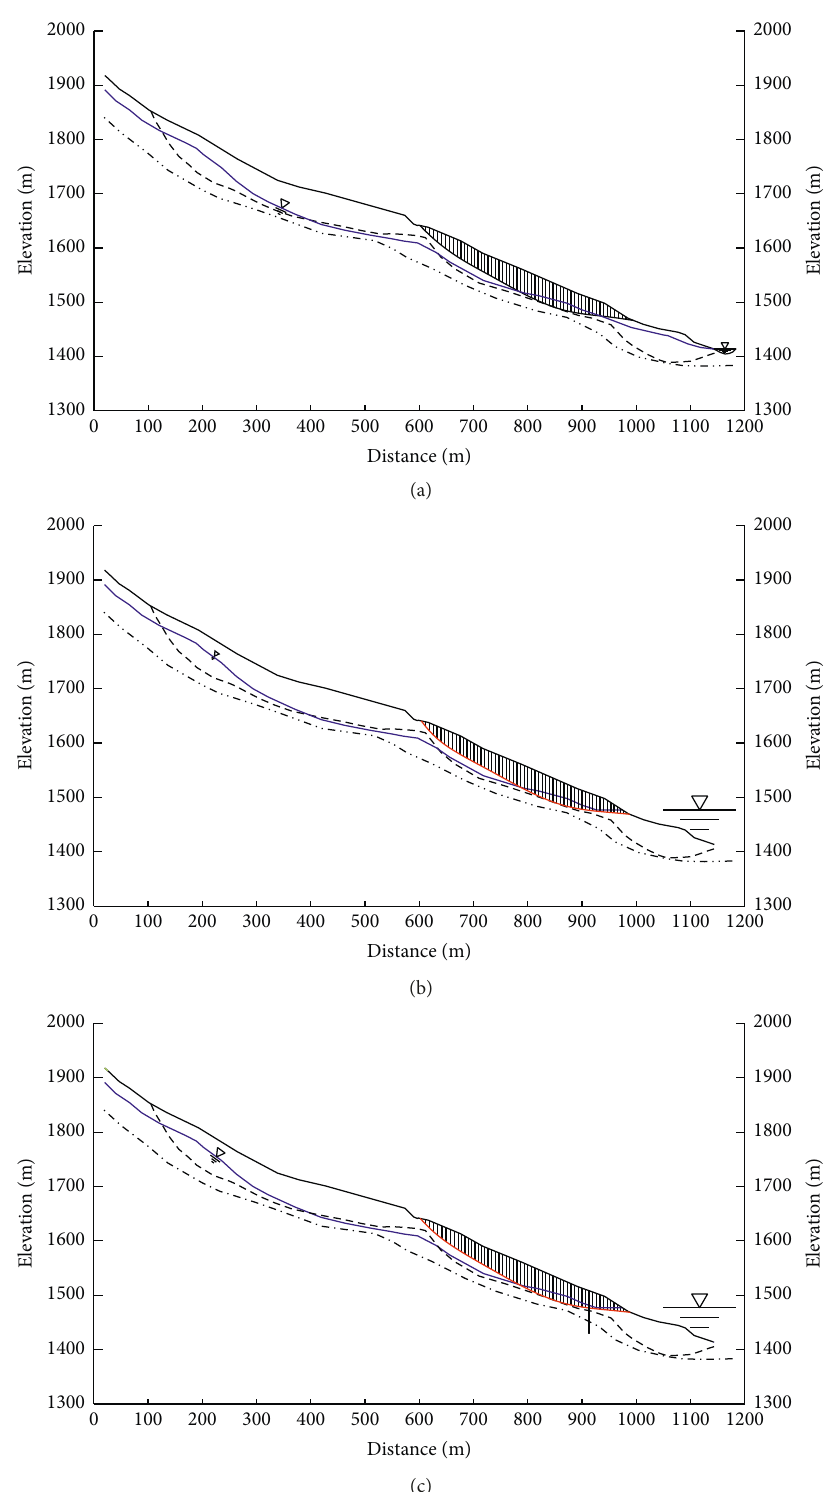
Figure 10: Stability analysis results and diagram of Dahua landslide subject to earthquake. (a) Before impoundment. (b) After im- poundment without stabilization measures. (c) After impoundment with stabilization